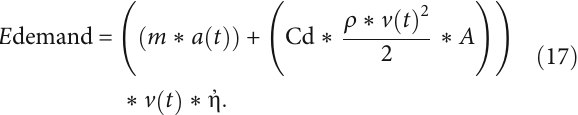
Figure 5: Li-ion battery discharge voltage